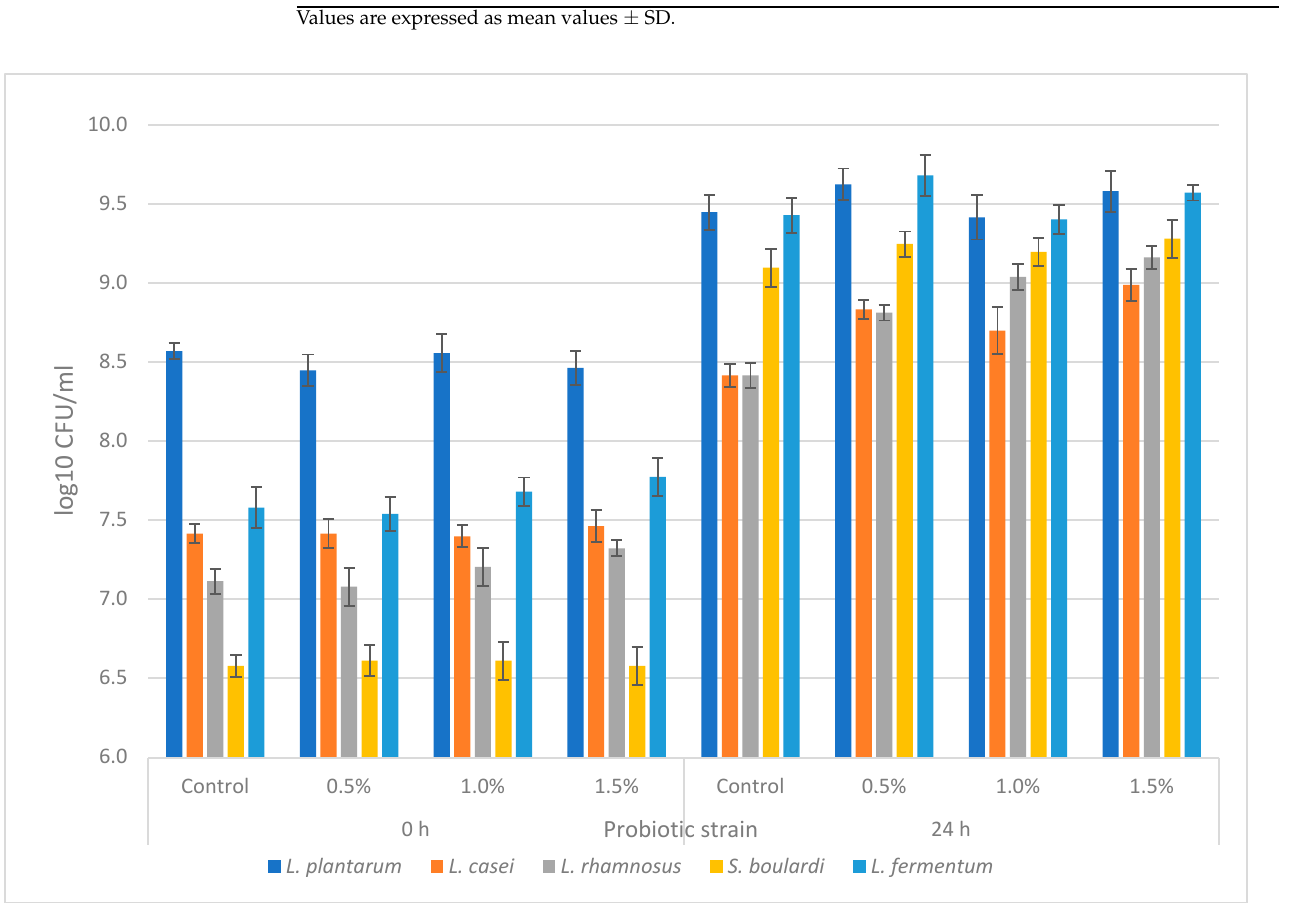
Figure 1. Cell viability of probiotic strains after inoculation and after 24 h ( n = 3 ).